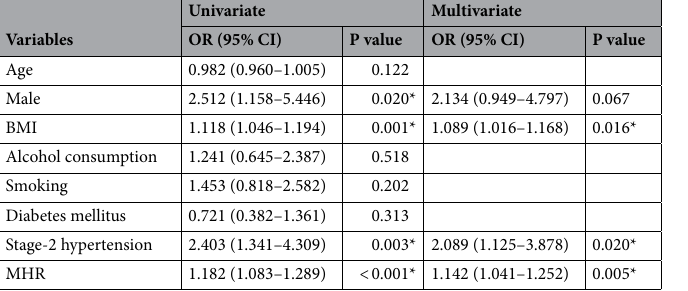
Table 5. Univariate and multivariate logistic regression analysis for severe OSA. BMI body mass index, MHR monocyte to high-density lipoprotein cholesterol ratio. *P value < 0.05.